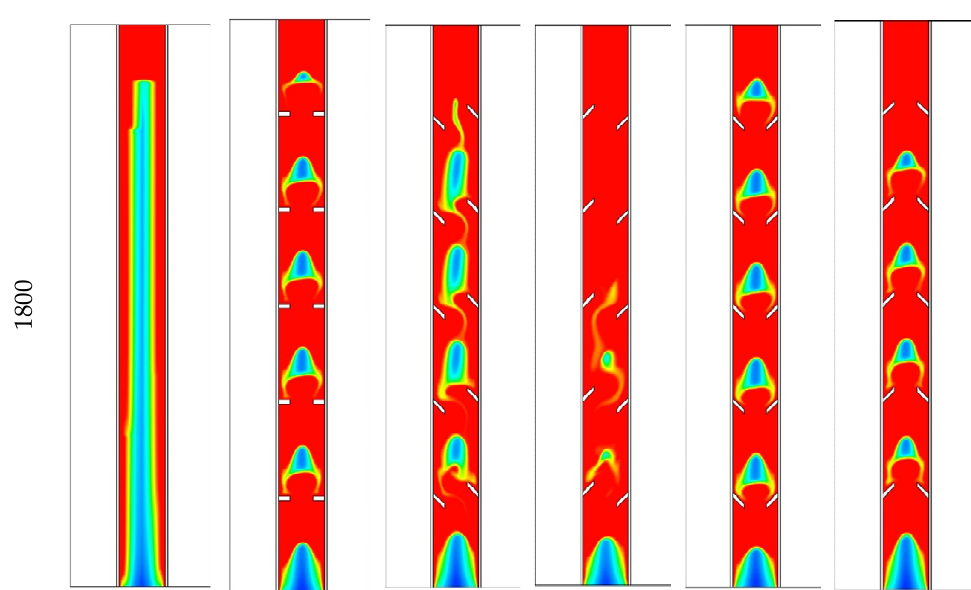
Figure 6. The liquid fraction development during 1800 s in three different time steps for the case of finless and the cases of different orientations of fins directions. Note that the right- and left-hand-side walls are the outer and the inner walls, respectively.